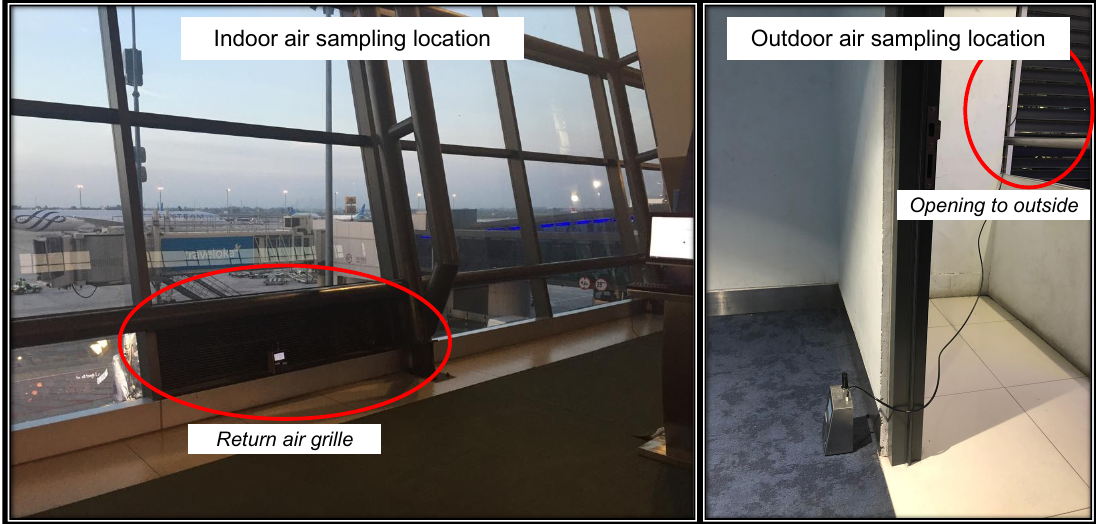
Figure 3. Sampling locations of the indoor and outdoor